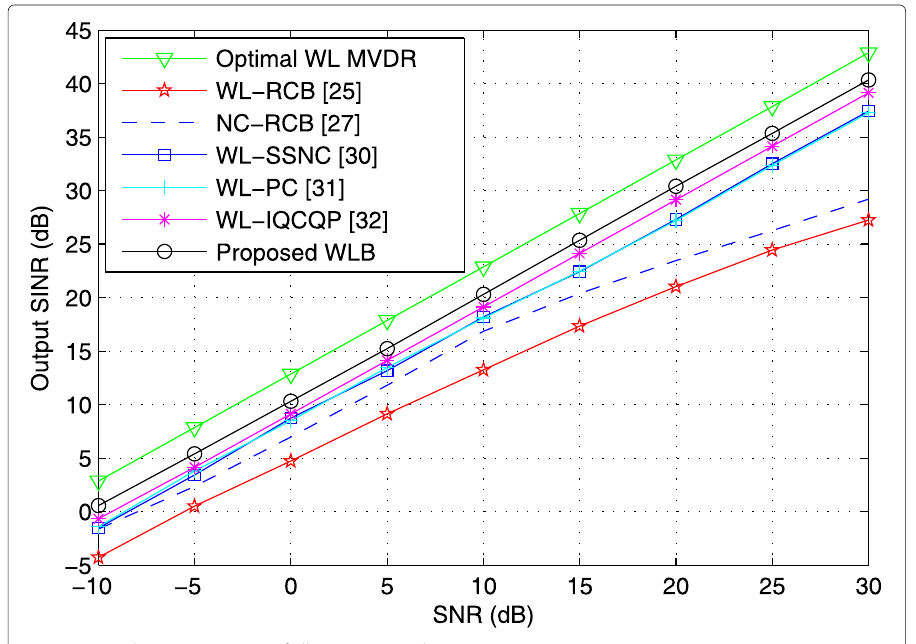
Fig. 6 Example 3. Output SINR of all WLBs versus the input